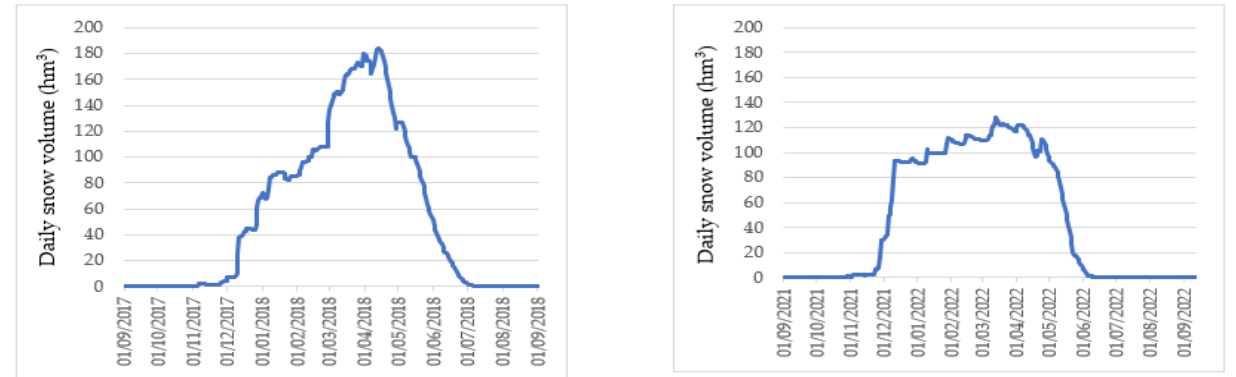
Figure 21. Evolution of snow volume in the upper Gállego River basin (up to the Búbal Reservoir). Hydrological year 2017/2018 ( left ) and 2021/2022 ( right ). Base data, daily snow volumes, expressed in hm 3 (equivalent volume of water). Data source and methodology: CHE-SAIH [49,51,52].